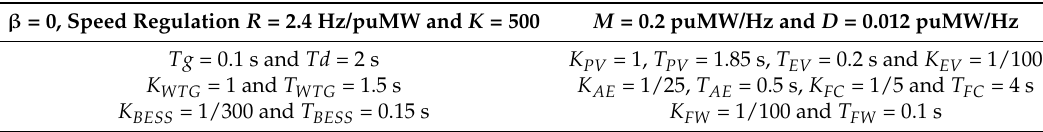
Table 1. Hybrid power system